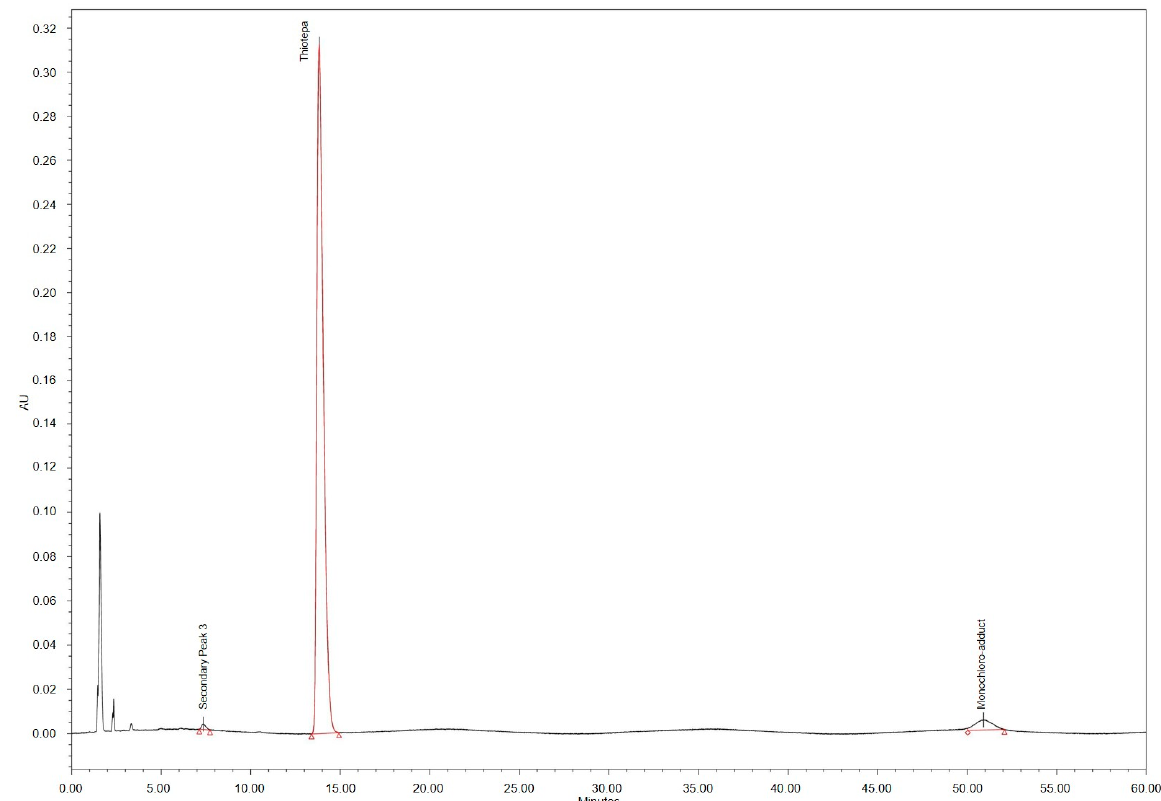
Figure 5. HPLC chromatogram of thiotepa 1 mg/mL infusion diluted with 0.9% NaCl solution stored at 25 °C for 14 days.